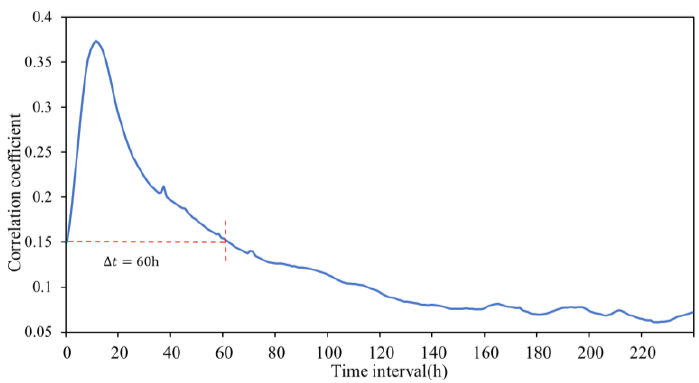
Figure 4. Correlation coefficients between rainfall and runoff.